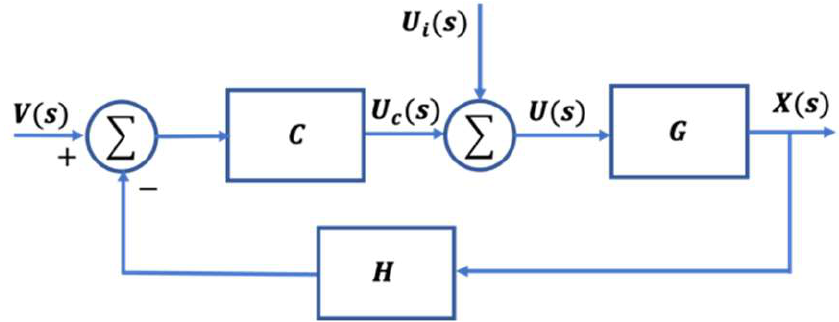
Figure 27. Control Architecture for Techniques 1–4 with Arbitrary Initial Conditions. Realization of U i ( s